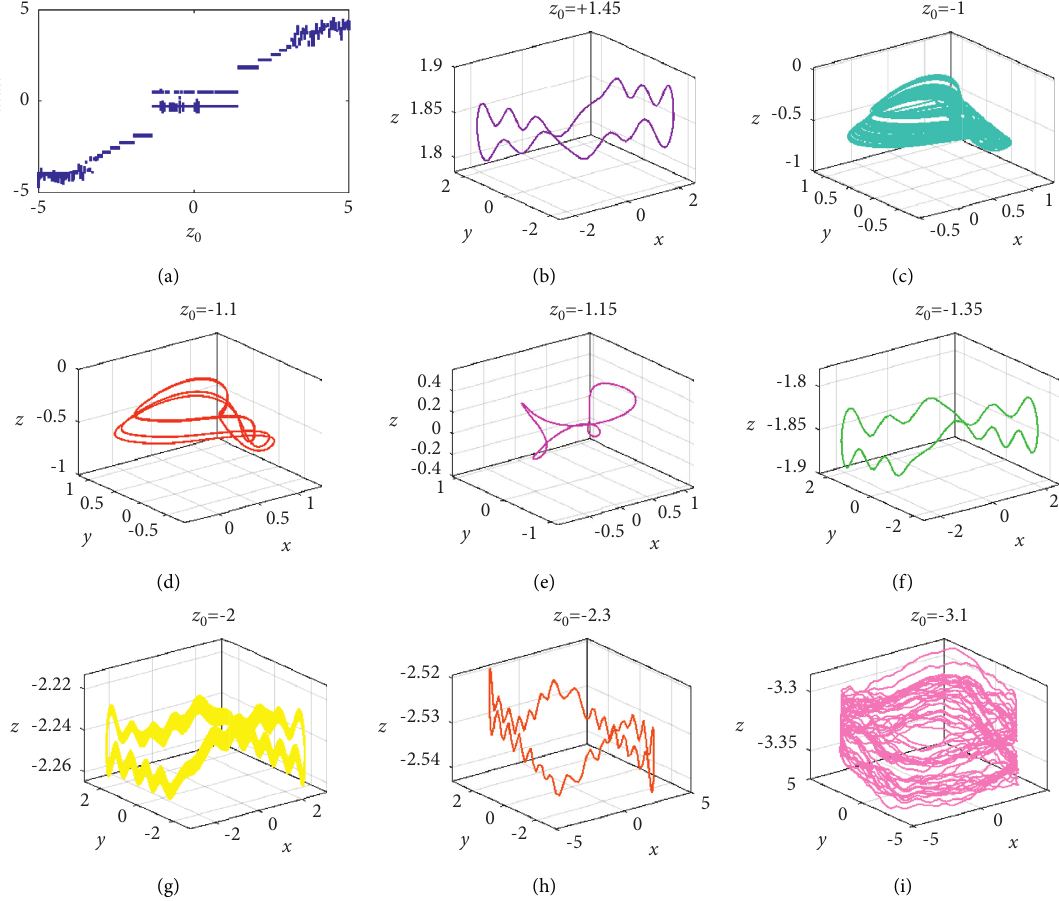
Figure 6: Sample phase portraits of system (1) under ( p occurrence of multiple attractors. (a) Bifurcation diagram of the system versus z cycle, (e, f) period-1 cycle with different topologies, (g) limit cycle, (h) period-1 cycle, and (i) limit